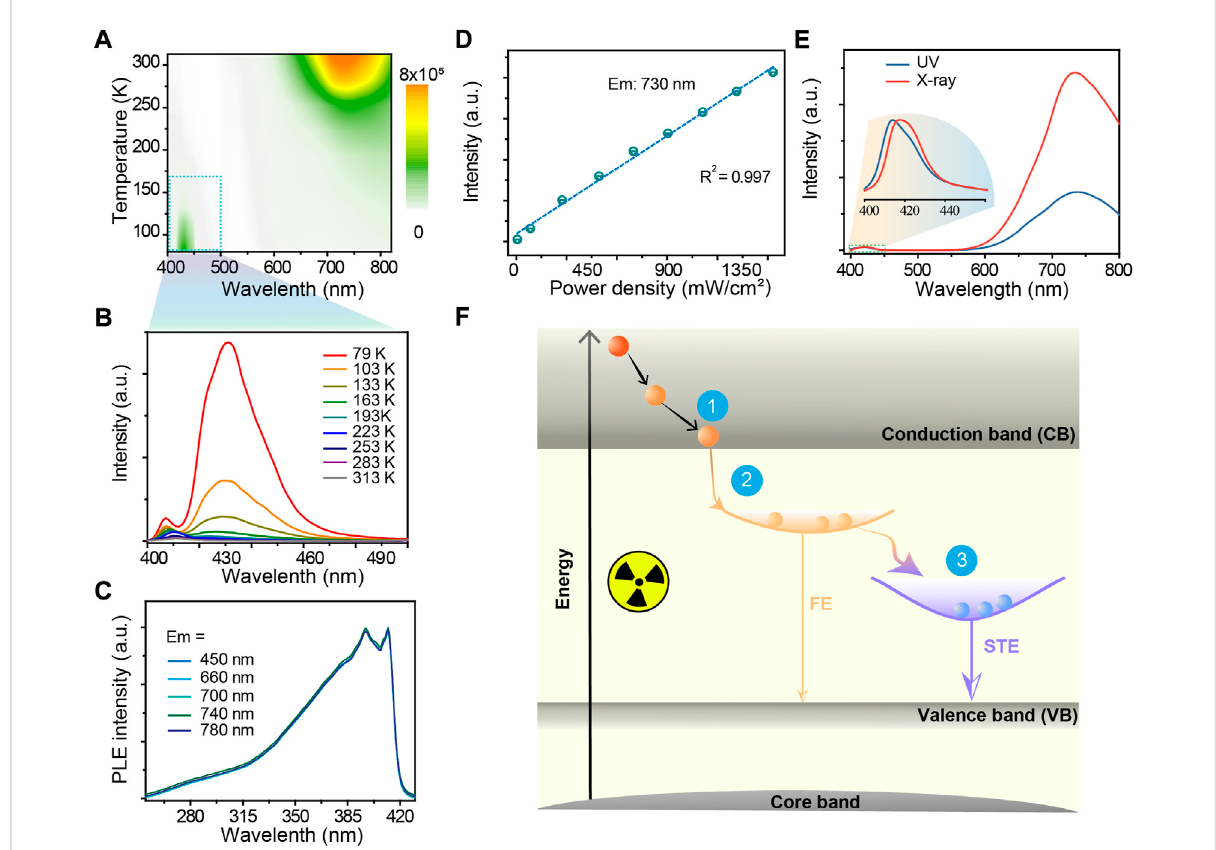
FIGURE 2 (A) Pseudo-color map of temperature-dependent photoluminescence spectra of the CuI microcrystals under UV illumination. (B) Temperature-dependent luminescence spectra of CuI microcrystals in the wavelength range of 400 – 500 nm under UV illumination. (C) Excitation spectra at various emissions from the CuI microcrystals. (D) Linear relationship between the fl uorescence emission intensity and the excitation energy; the excitation wavelength was set at 360 nm (E) Fluorescence emission spectra of CuI microcrystals under UV and X-ray excitations, respectively. The data were normalized with the free exciton emission peak. (F) Proposed mechanism of X-ray luminescence in CuI microcrystals. Process one is the energy relaxation process, Process two is the process of forming free excitons, and Process three is the exciton self-trapping